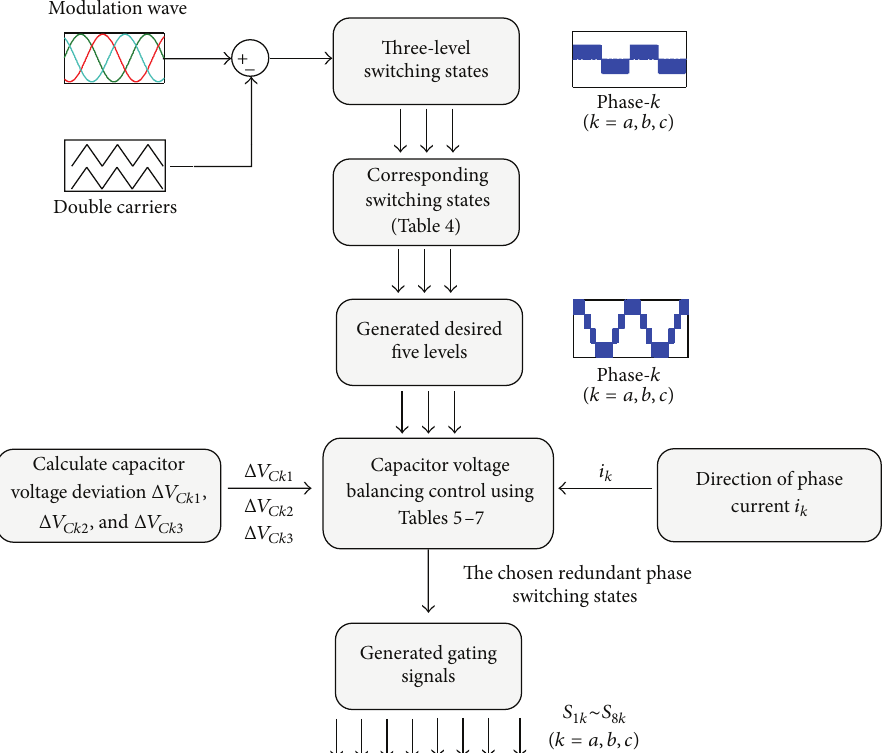
Figure 4: The control diagram of the novel five-level inverter.